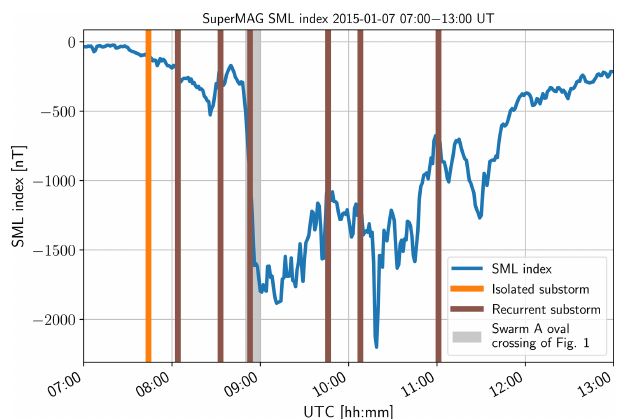
Figure 2. An example time series of the SML index with the iso- lated and recurrent substorm onsets marked with vertical lines. The grey shading shows the relation of the oval crossing of Fig. 1 to the SML time